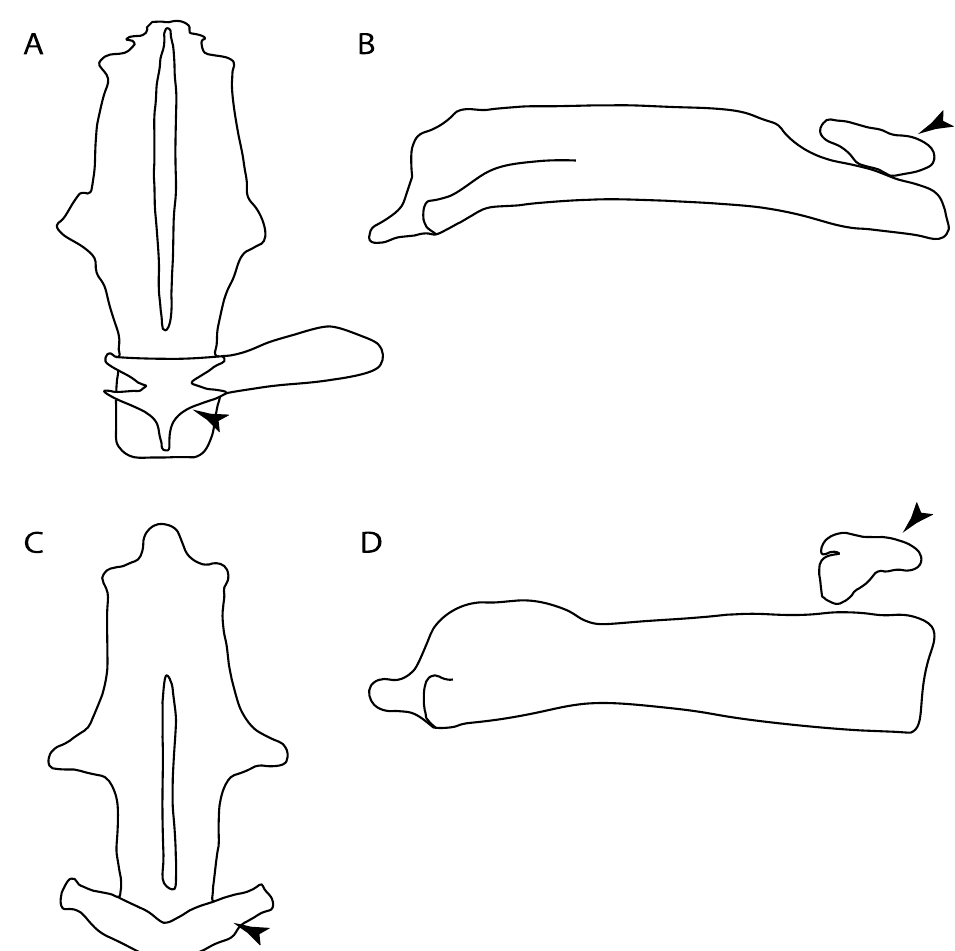
Figure 30. Dorsal and lateral view of synarcual and suprascapula. Interpretative drawing of: State (0): ( A , B ) Trygonorrhina sp. (uncatalogued) redrawn and modified from Claeson Text-Figure 5.16A in [71]. State (1): ( C , D ) Narcine brasiliensis (AMNH 77069, https://sharksrays.org/ (accessed on13 April 2020)). Arrowheads: suprascapula.